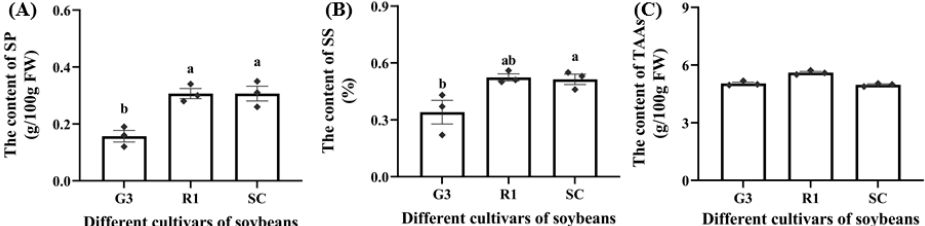
Figure 1. The content of soluble protein ( A ), soluble sugar ( B ) and total amino acids ( C ) in different soybean cultivars (G3, R1, SC). Data are means ± SEM. The lowercase letters in the figure indicate significant differences among different cultivars ( p < 0.05, Tukey test). FW: fresh weight; SP: soluble protein; SS: soluble sugar; TAAs: total amino acids. Table 1. The content (g/100g FW) of amino acids in di ff erent soybean cultivars. Amino Acids